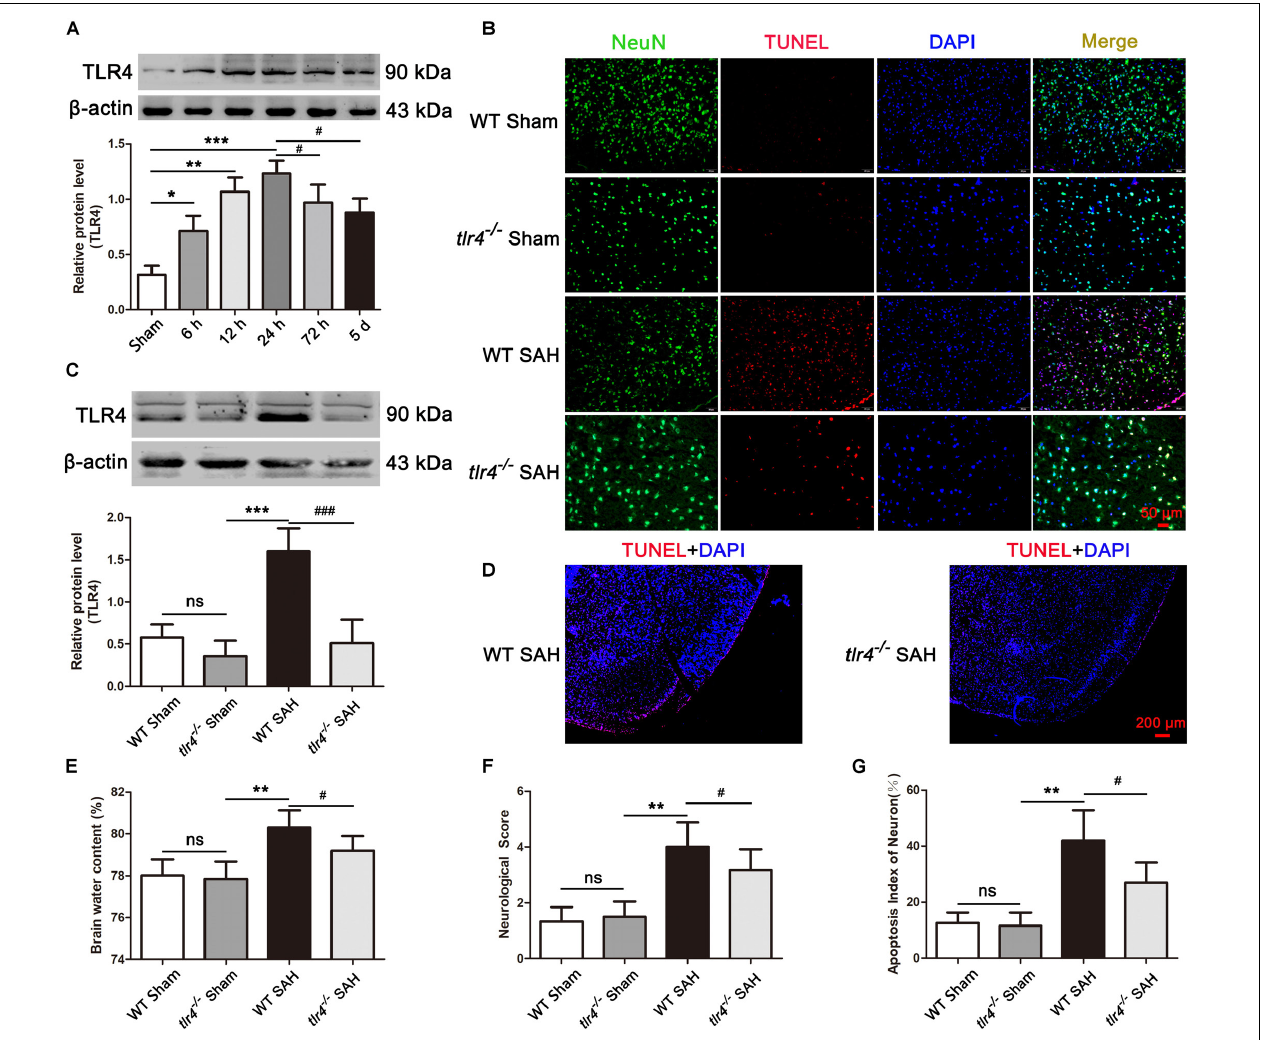
FIGURE 3 | Effects of toll-like receptor 4 (TLR4) deficiency on brain water content, neurological deficit and neural death after SAH. (A) SAH induction increased the level of TLR4 and peaked at 24 post SAH. (B,G) TLR4 deficiency decreased the TUNEL-positive neurons compared with the wild type (WT) SAH group at 24 h